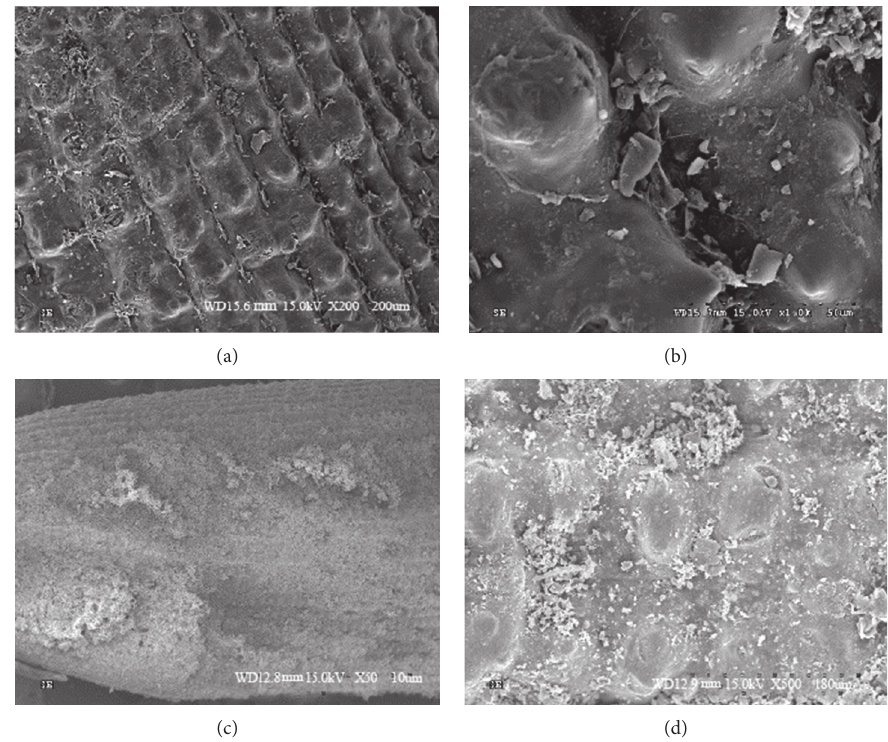
Figure 8: SEM of rice husk mortar surface. (a) Rice husk in mortar magnified 100 times. (b) Rice husk in mortar magnified 1000 times. (c) Rice husk in mortar magnified 50 times. (d) Rice husk in mortar magnified 500